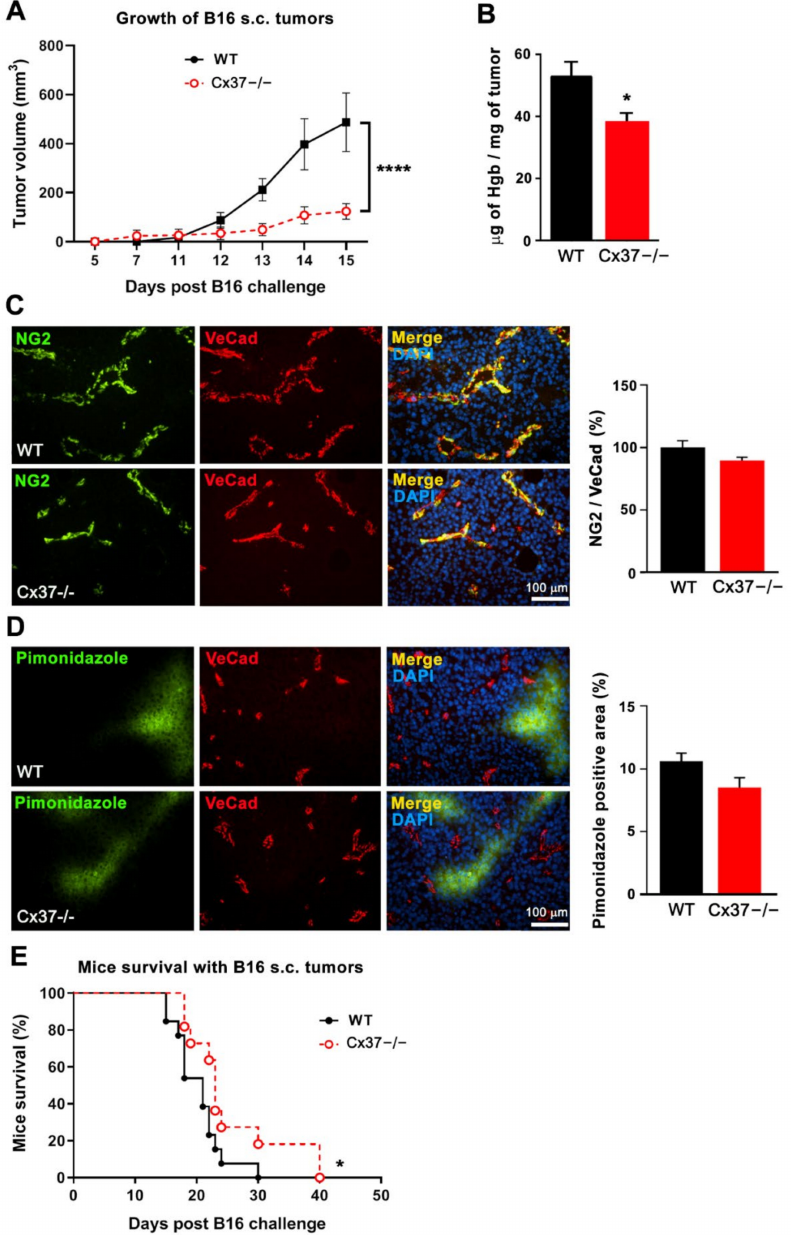
Figure 6. Loss of Connexin37 decreases the growth of B16-F10 tumors and extends the survival of the tumor-bearing mice. B16-F10 cells were s.c. injected to generate tumors in WT and Cx37 − / −